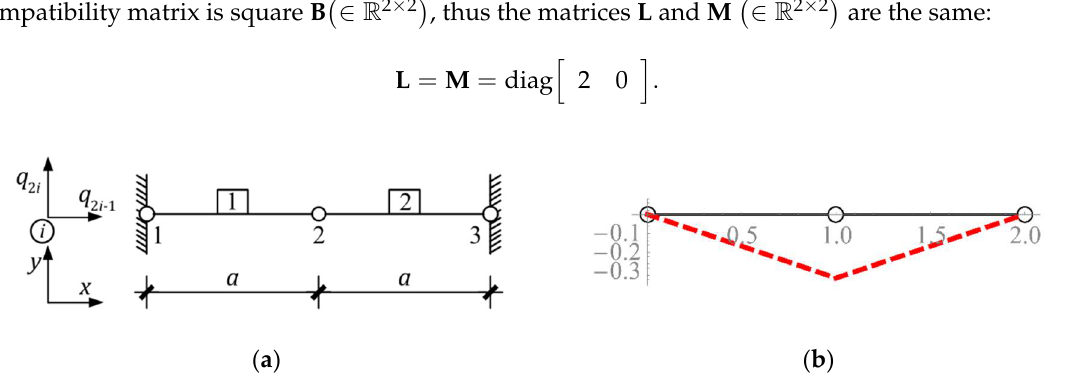
Figure 9. Mechanisms of pure tensegrity trusses.